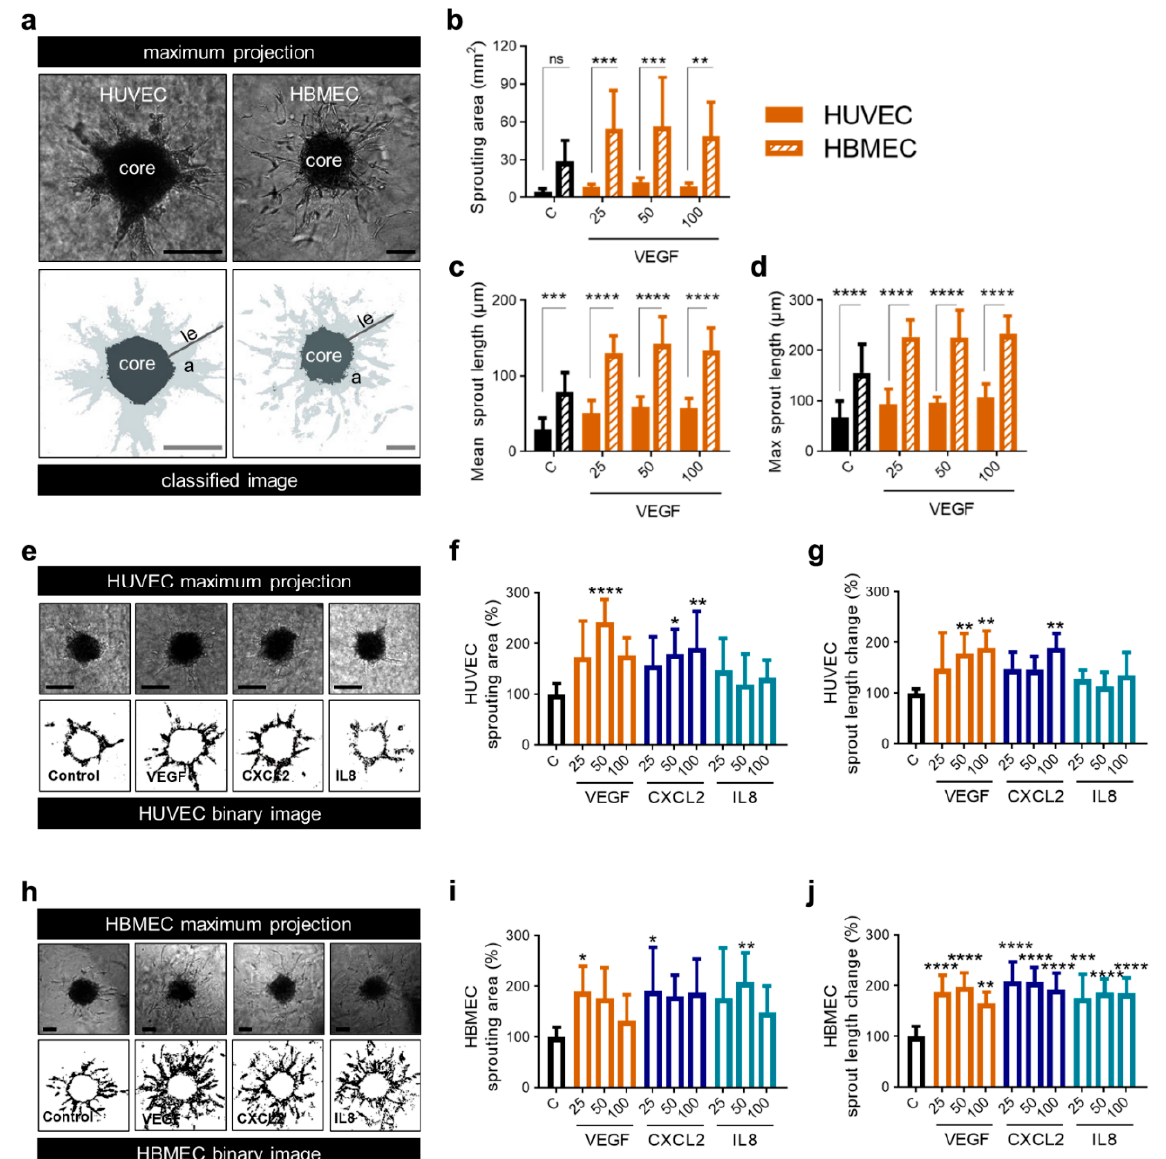
Figure 5. CXCL2 and IL8 show enhanced angiogenic capacity on brain endothelial cells compared to VEGF. ( a – d ) 3D Sprouting assay of HUVEC and HBMEC spheroids was performed in response to the treatment with VEGF as indicated (25, 50 and 100 ng/mL). Representative images show the maximal projection and the binary image of spheroids Scale bars 100 µ m. le: length, a: area (light grey) ( a ). Sprouting area ( b ), mean sprout length ( c ) and maximum sprout length ( d ) of HUVEC and HBMEC spheroids were calculated. Graphs represents multiple experiments with similar results ( n = 8–12 spheroids/condition). ( e – g ) 3D Sprouting assay of HUVEC spheroids was performed in response to the treatment with VEGF, CXCL2 and IL8 as indicated (25, 50 and 100 ng/mL). Representative images show the maximal projection and the binary image of spheroids. Scale bars 100 µ m ( e ). Sprouting area ( f ) and mean sprout length change ( g ) were calculated. Data represent multiple experiments with similar results ( n = 6–10 spheroids/condition). ( h – j ) 3D Sprouting assay of HBMEC spheroids was performed in response to the treatment with VEGF, CXCL2 or IL8 as indicated (25, 50 and 100 ng/mL). Representative images show the maximal projection and the binary image of spheroids. Scale bars 100 µ m ( h ). Sprouting area ( i ) and mean sprout length change ( j ) were calculated. Data represent multiple experiments with similar results ( n = 7–12 spheroids/condition). ( a – j ) Medium containing 0.1% FCS was used as control (C). ns = not significant, * p < 0.05, ** p < 0.01, *** p < 0.001, **** p < 0.0001; one-way ANOVA (Bonferroni